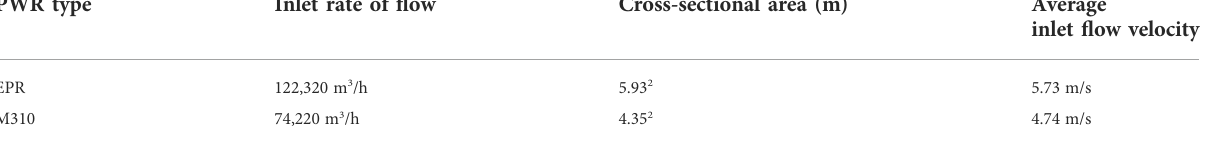
TABLE 5 Inlet rate of fl ow and velocity.